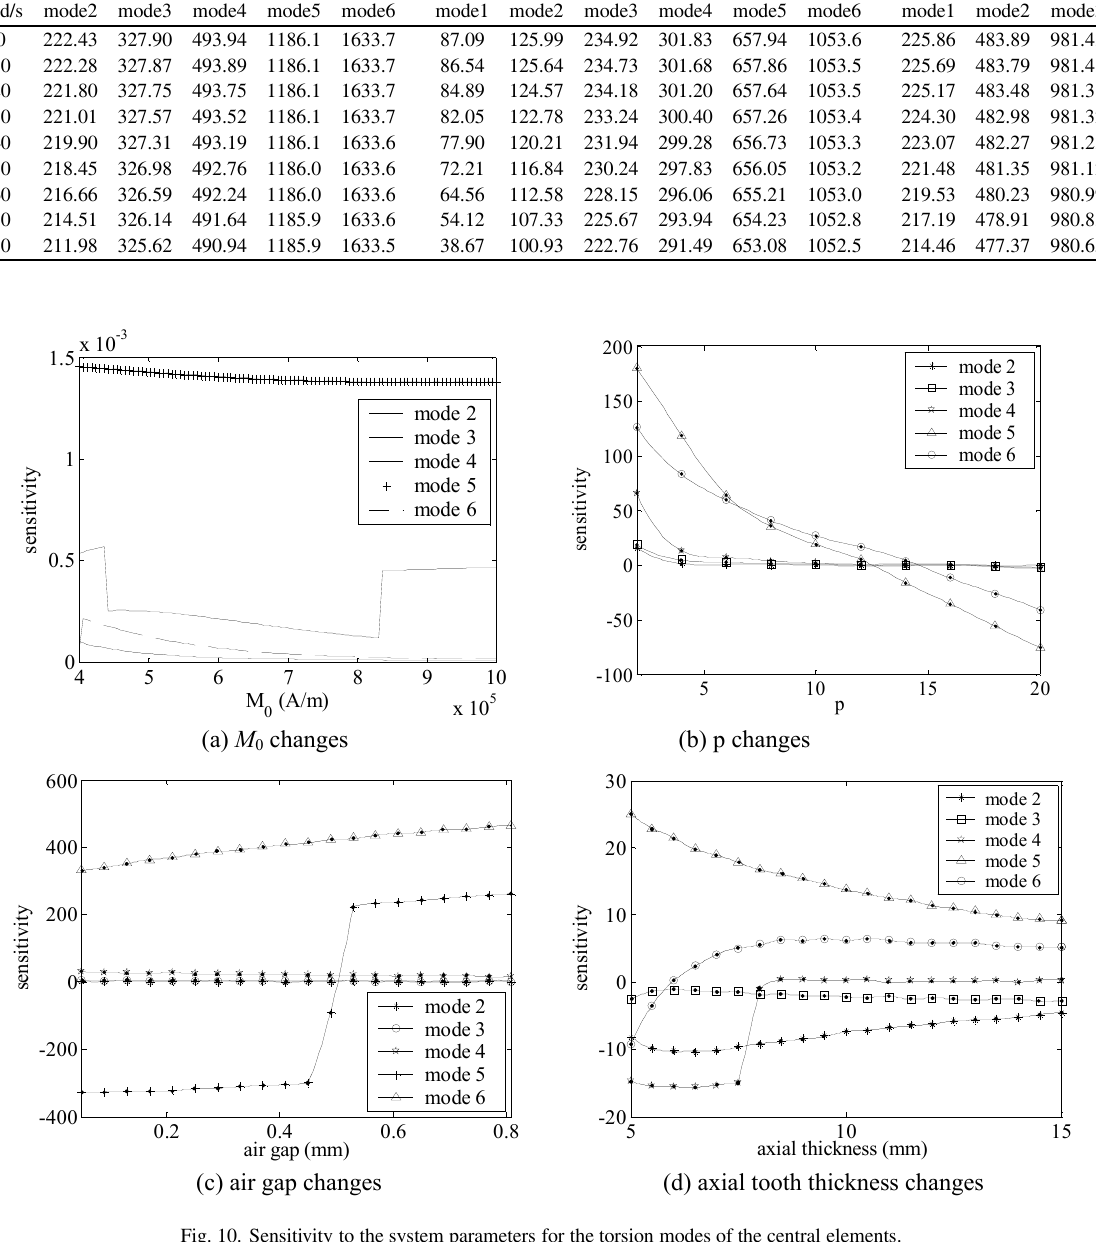
Fig. 10. Sensitivity to the system parameters for the torsion modes of the central